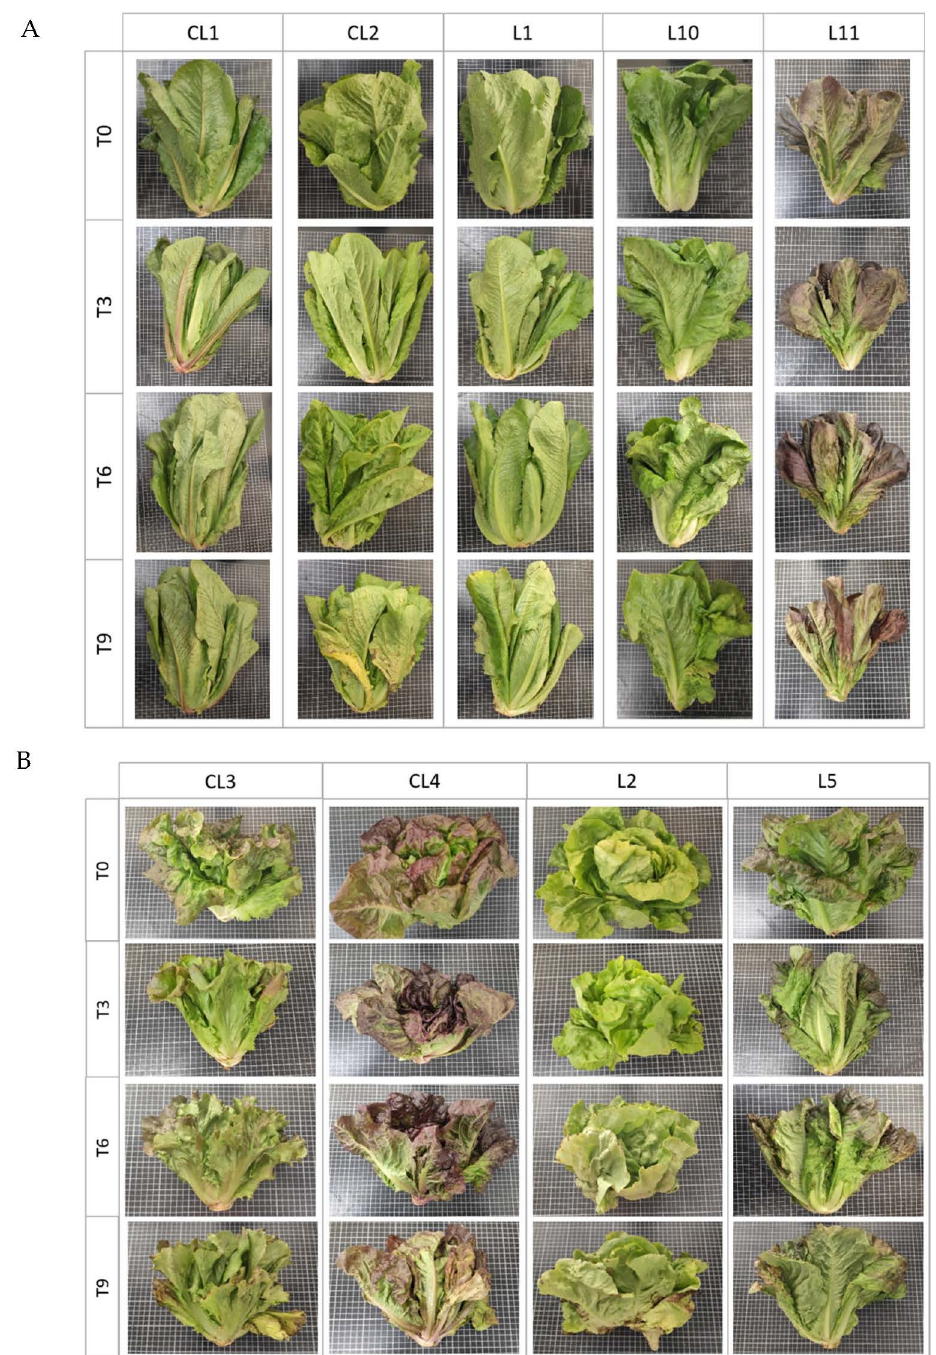
Figure 1. Pictures of the nine cultivated lettuce varieties ( Lactuca sativa L.) provided by the Germplasm Banks from COMAV (Valencia, Spain) and the IVIA (Moncada, Spain) at 0 (T0), 3 (T3), 6 (T6) and 9 (T9) days after conservation under chamber conditions. The size of the grid cells in the fruit pictures is 1 cm × 1 cm. ( A ) Lettuce varieties with no patent head; ( B ) lettuce varieties with a prominent head.